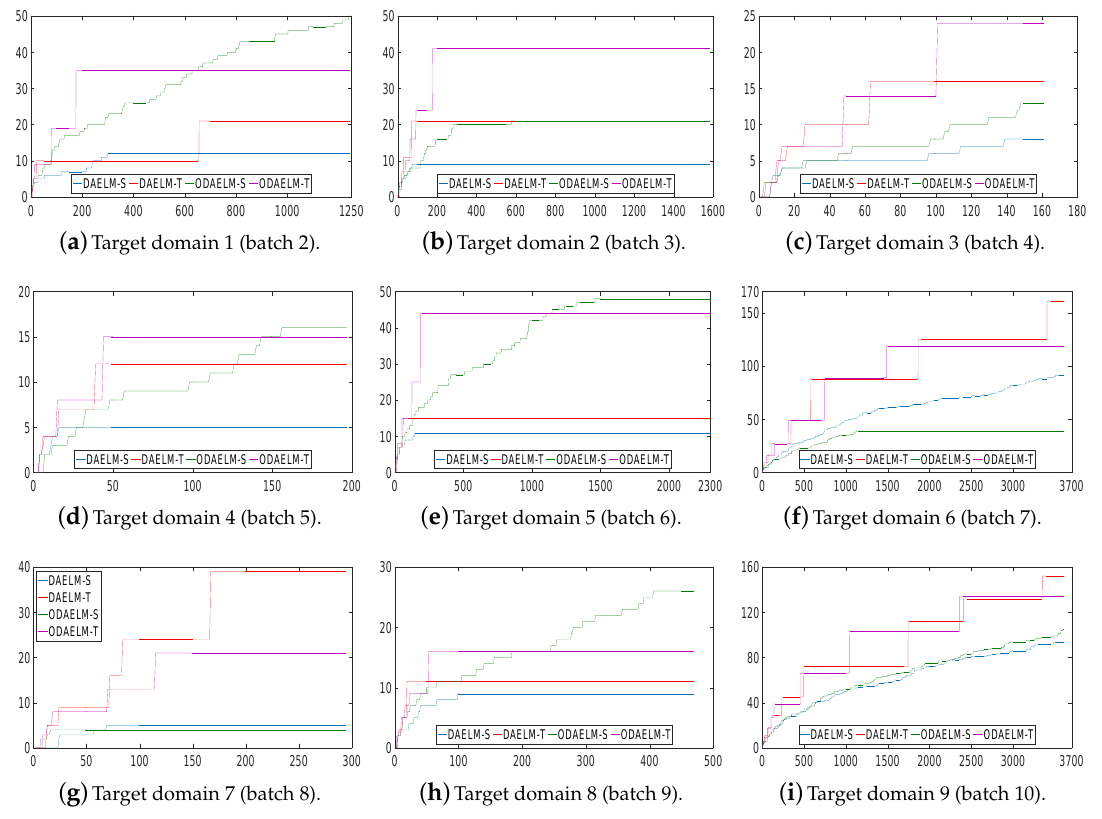
Figure 12. Numbers of labeled samples in nine target domains using setting 3. The x - and y -axes are the same as Figure